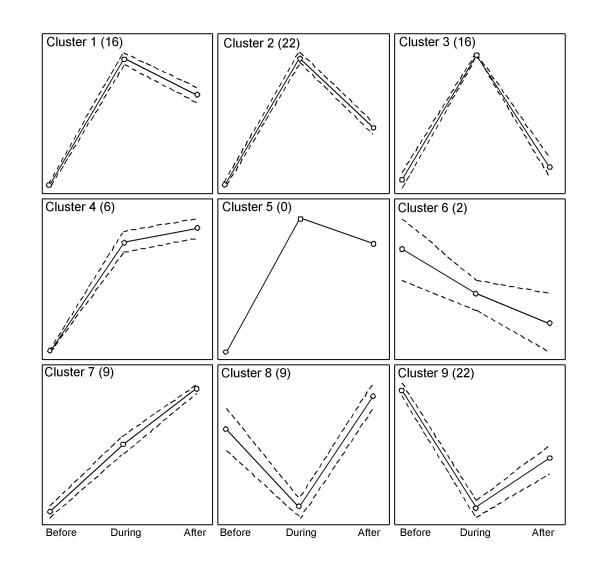
Cluster analysis of DNA microarray data from samples before, during and after cardiac rejection. Cluster analysis of DNA microarray data from endomyocardial biopsie samples from three subjects before, during and after cardiac rejection. Nine clusters were generated by SOM clustering containing 0–22 genes. The mean profile of the cluster members are indicated by solid lines and the dashed lines indicate standard deviation. The number of cluster members is indicated within parenthesis. Circles indicate the analysed time-points in the histopathological sequence (before, during and after rejection).